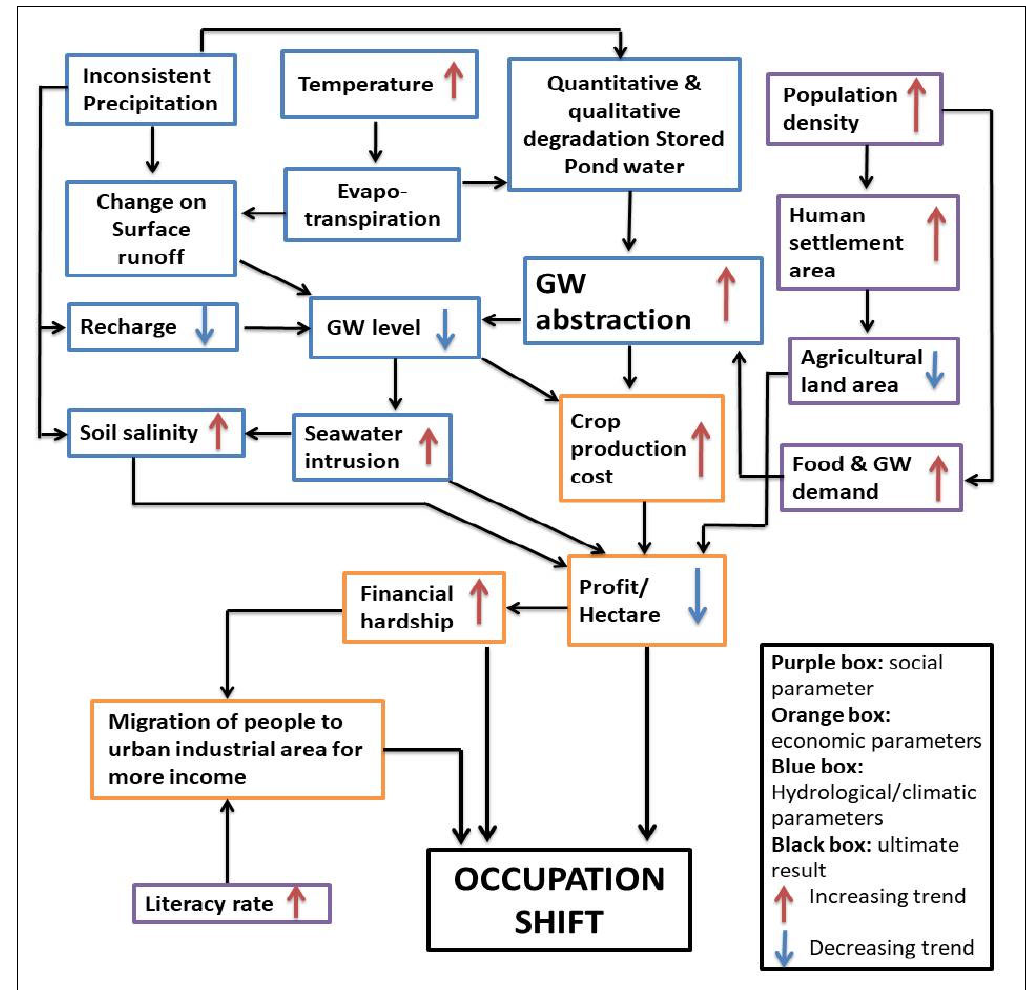
Figure 16. The drivers of socio ‐ economic trend/status under hydroclimatic context in the study area.